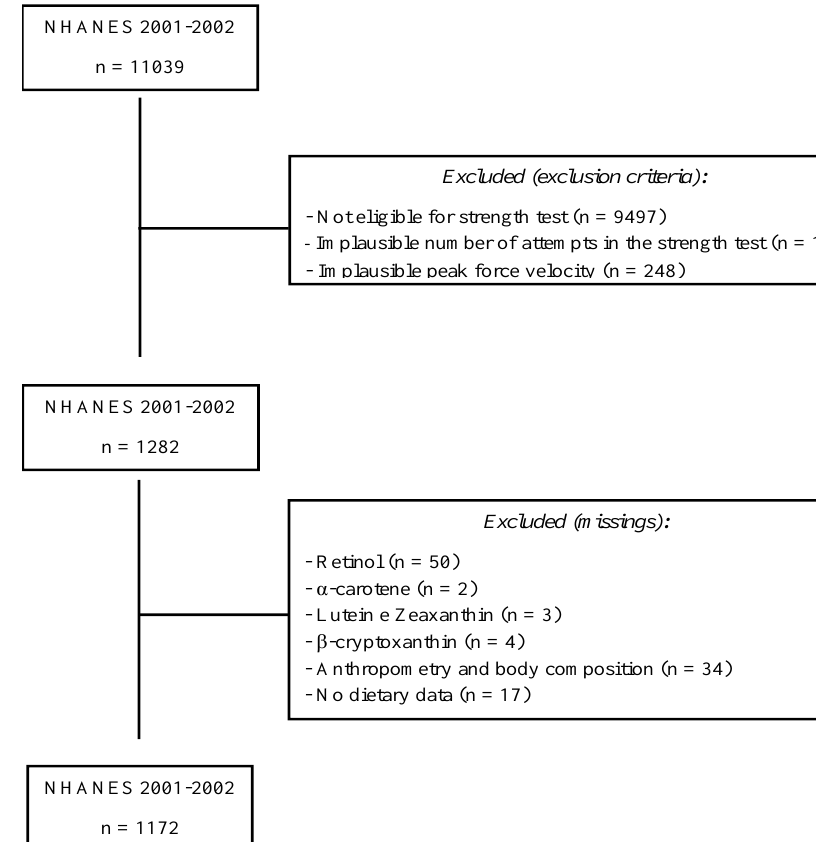
Figure 1. Flowchart of the sample selection from NHANES